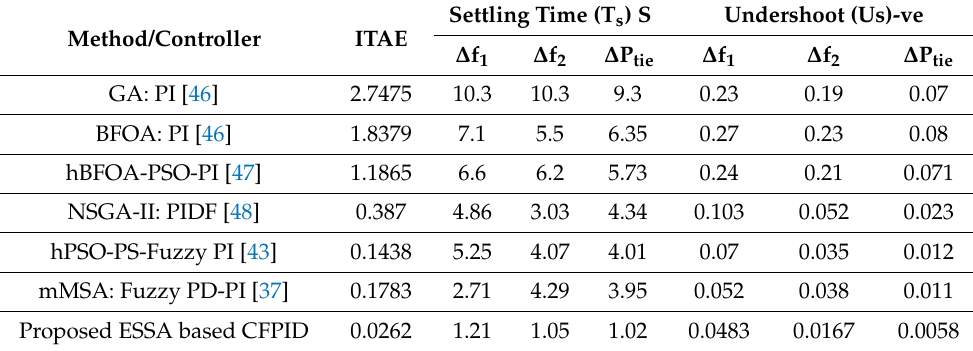
Table 7. Performance with different controllers for 1st test